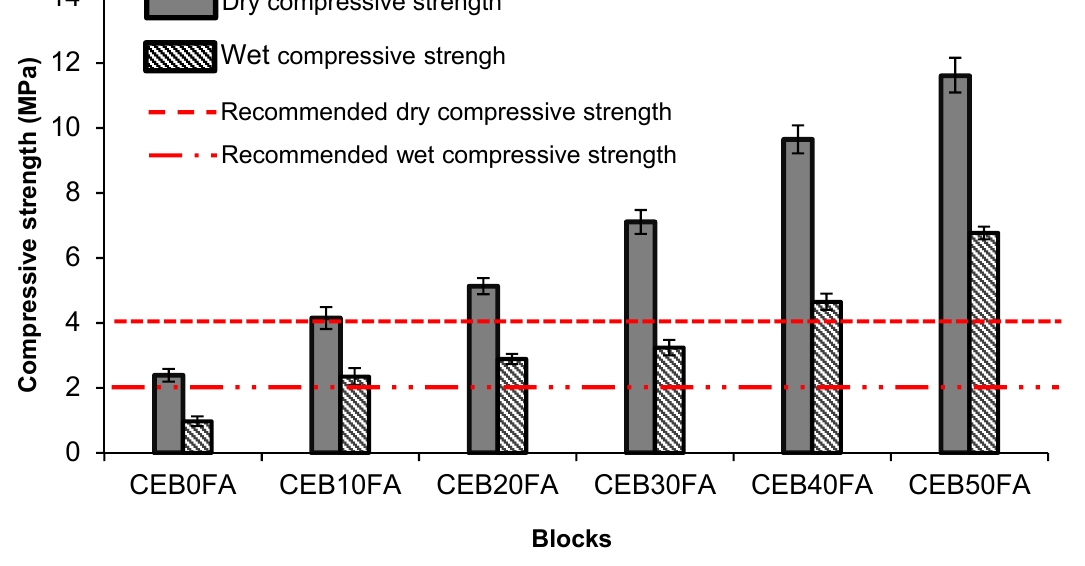
Figure 8. Dry and wet compressive strength of CEBs after 28 Figure 5. Dry and wet compressive strength of CEBs after 28 days.